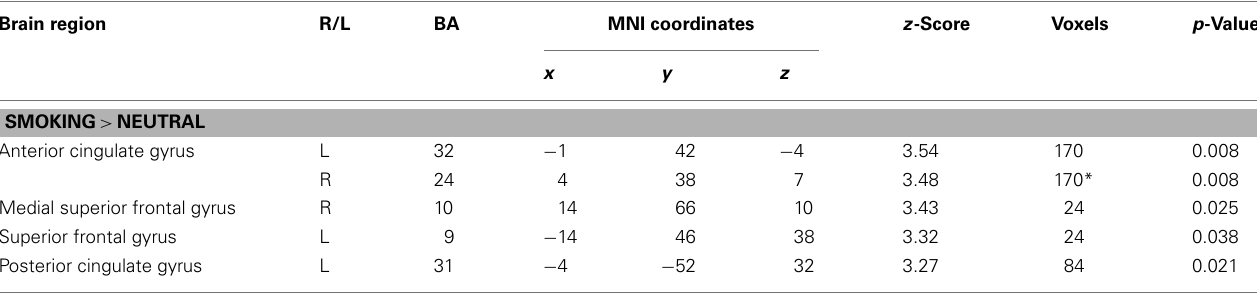
Table 2 | ROI activations during viewing of appetitive cigarette and neutral images.